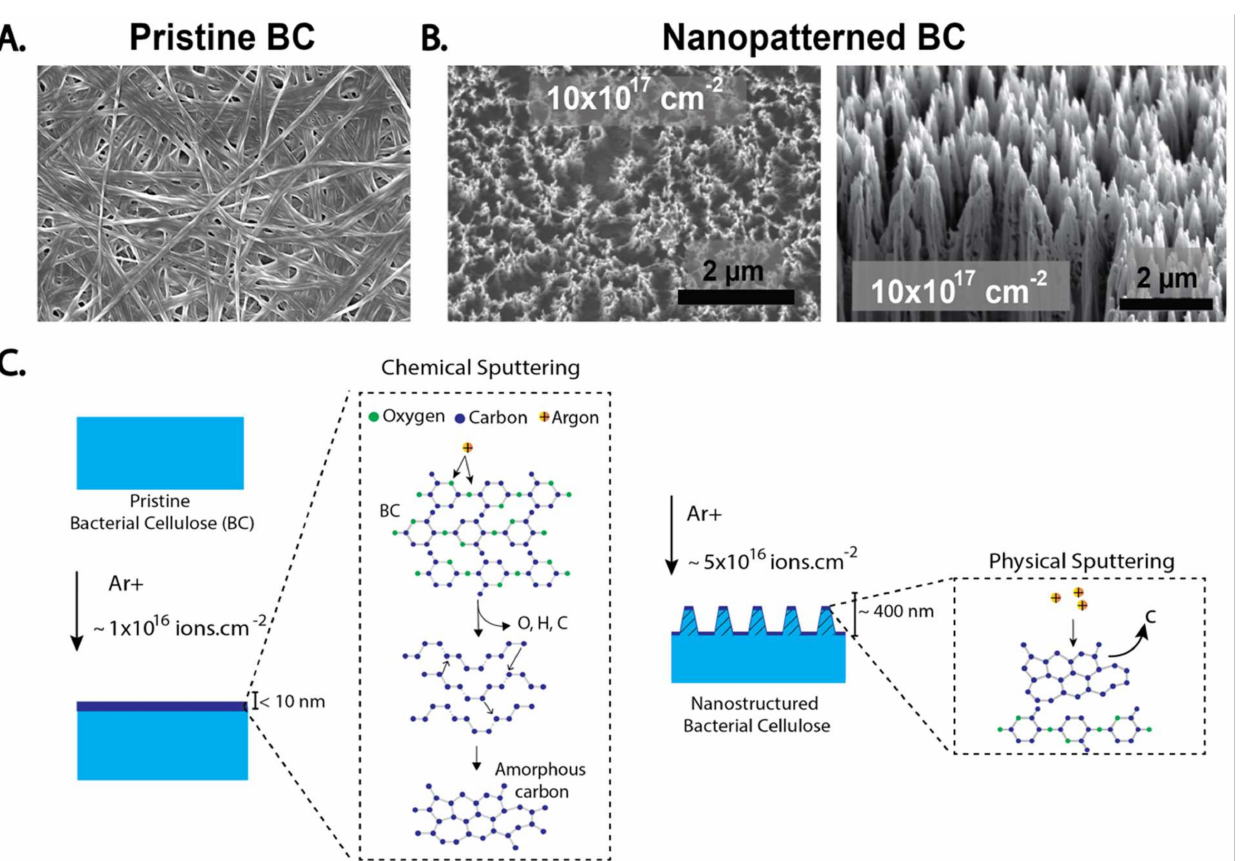
Figure 6. SEM images of ( A ) pristine BC ( B ) irradiated BC. ( C ) Chemical and physical sputtering of BC surface. Reproduced with permission from [19] (Copyright © 2022, American Chemical